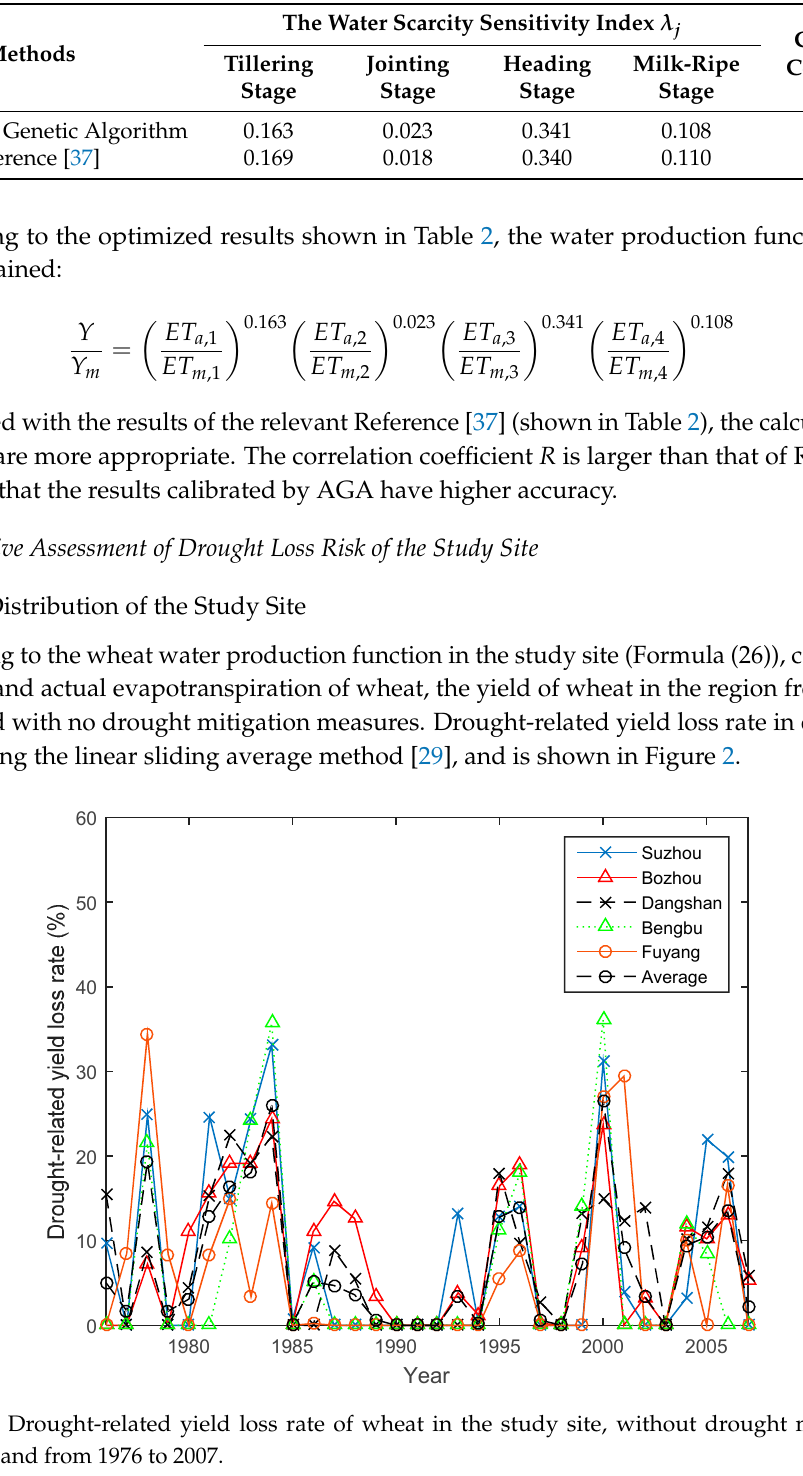
Table 2. The water scarcity sensitivity index λ j calibrated by the different methods for different growth periods in the study site.